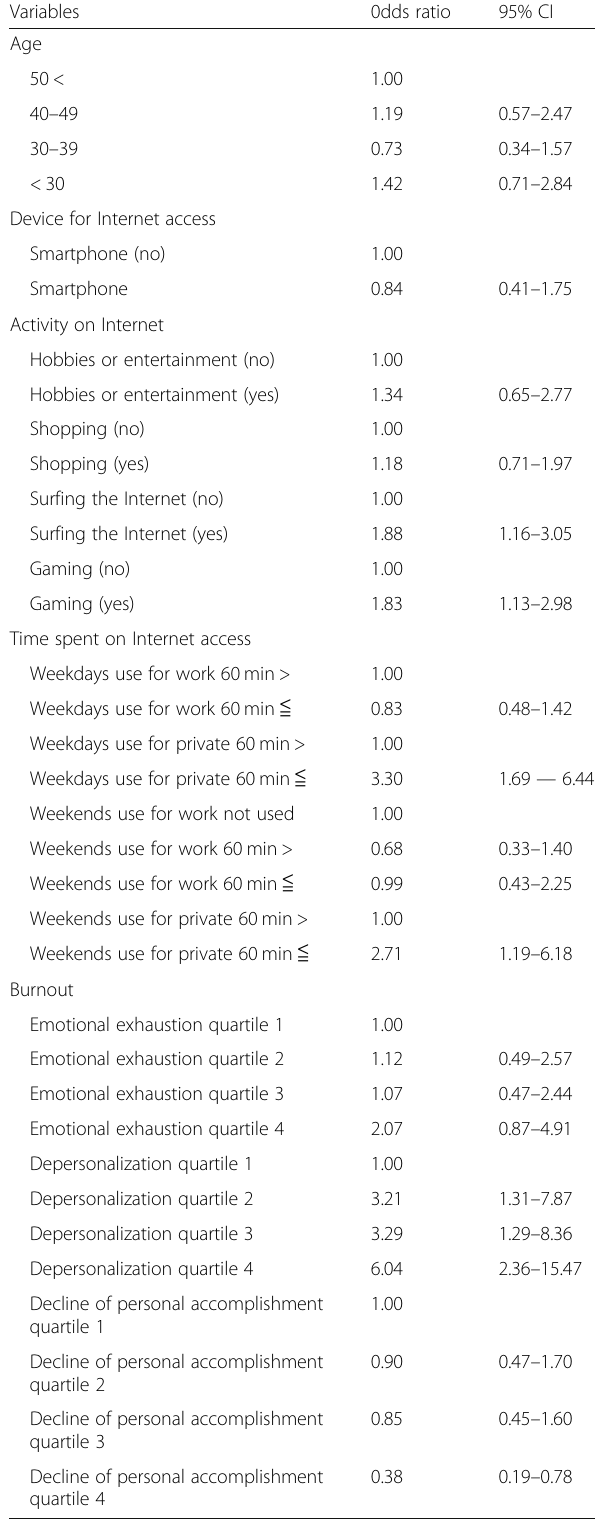
Table 4 Multivariate odds ratio and 95% confidence intervals for at-risk IA